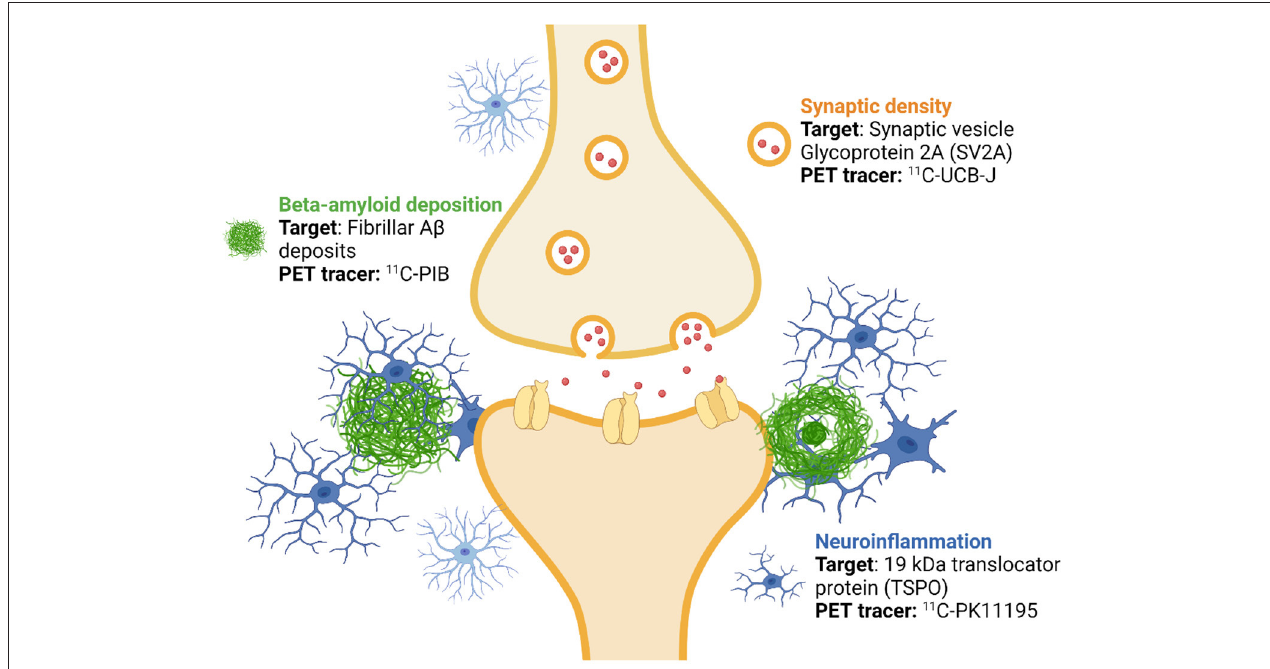
FIGURE 1 | Imaging targets and used positron emission tomography (PET) tracers. ASIC-E4 is a prospective, observational multi-tracer imaging study, where three different positron emission tomography (PET) tracers are used to investigate beta-amyloid (A β ) deposition, activation of glial cells and synaptic density in individuals with three levels of genetic ( APOE- related) risk for sporadic Alzheimer’s disease. The figure was created with